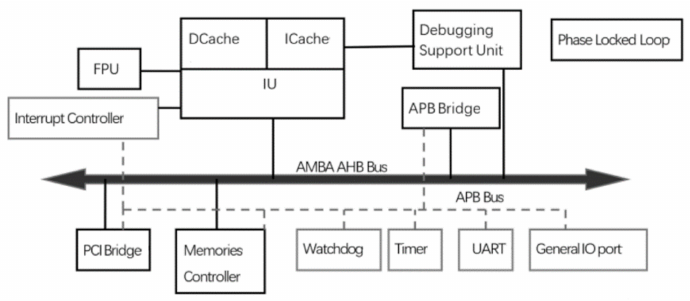
Figure 1. Functional block diagram of the